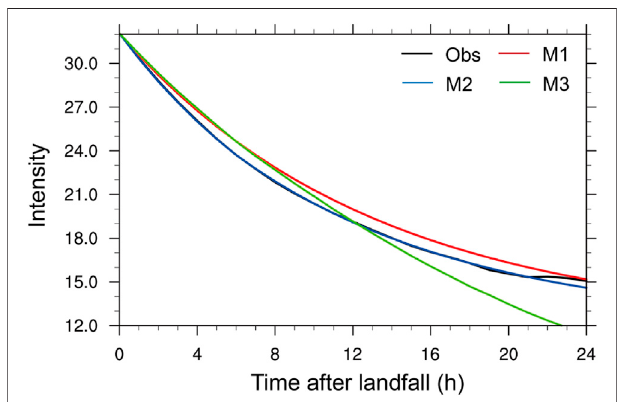
FIGURE2| Themeandecaycurvesofmaximumsustainednearsurface wind (m s − 1 ) for landfalling TCs over China during 1980 – 2018 from CMA dataset (black), and from M1 (red), M2 (blue), and M3 (green).